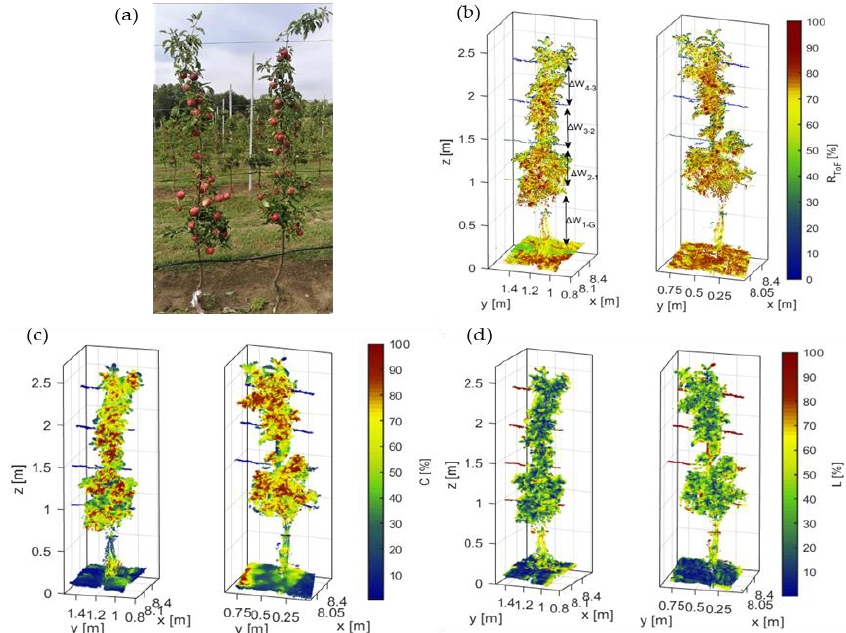
Figure 3. Representation of 3D point clouds of ( a ) RGB image ( b ) reflectance (R ToF ) [%], ( c ) curvature ( C ) [%] and ( d ) linearity ( L ) [%] of trees measured with leaves at DAFB 120 .